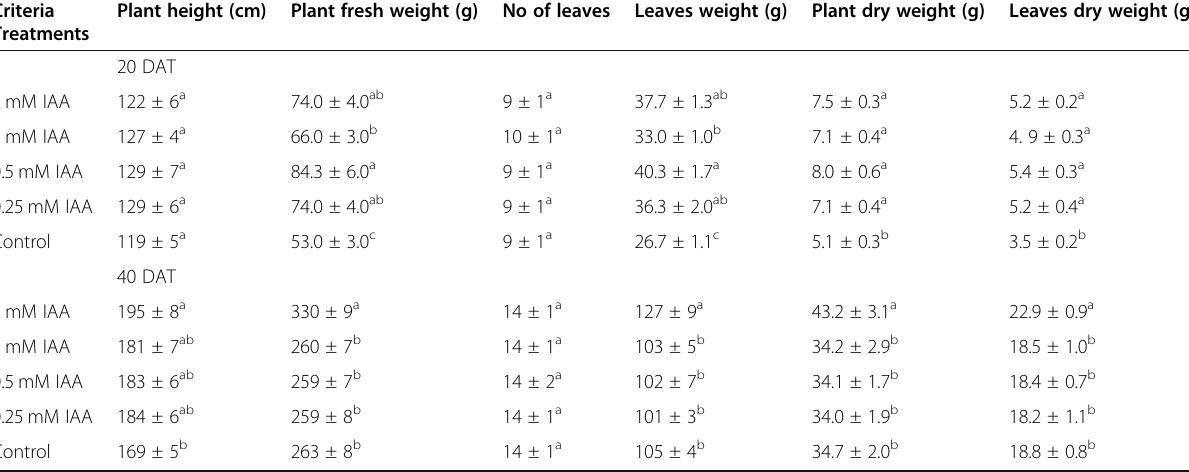
Table 5 Effect of IAA foliar spray on vegetative growth of maize plants Criteria